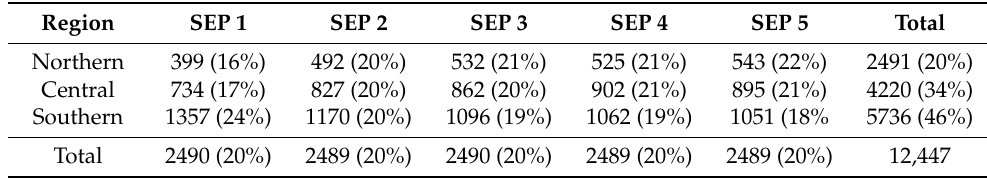
Table 1. The numbers (and percentages) of the households interviewed in IHS4 (2016–2017) by socioeconomic position and